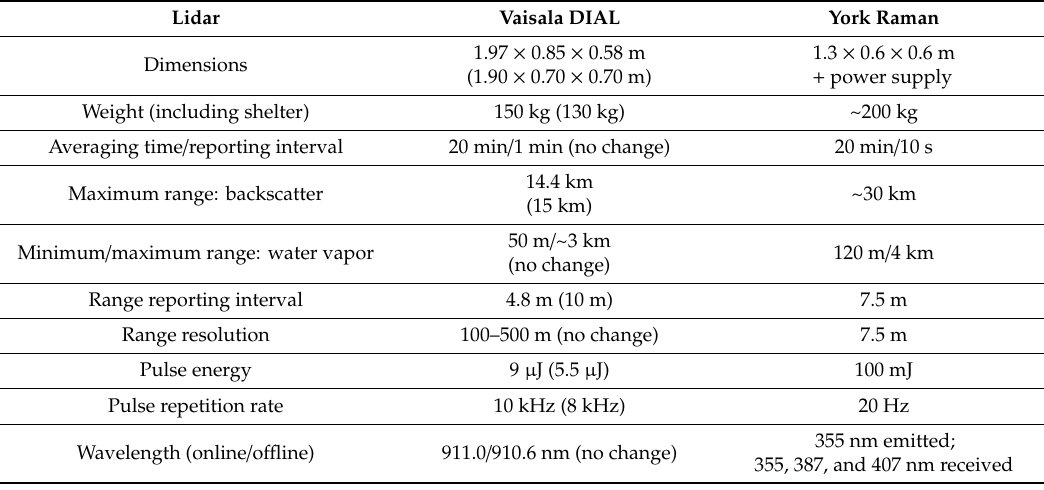
Table 1. Primary technical specifications of the Vaisala DIAL and York Raman lidar. Information in brackets indicate specifications from the prototype DIAL deployed to the Southern Great